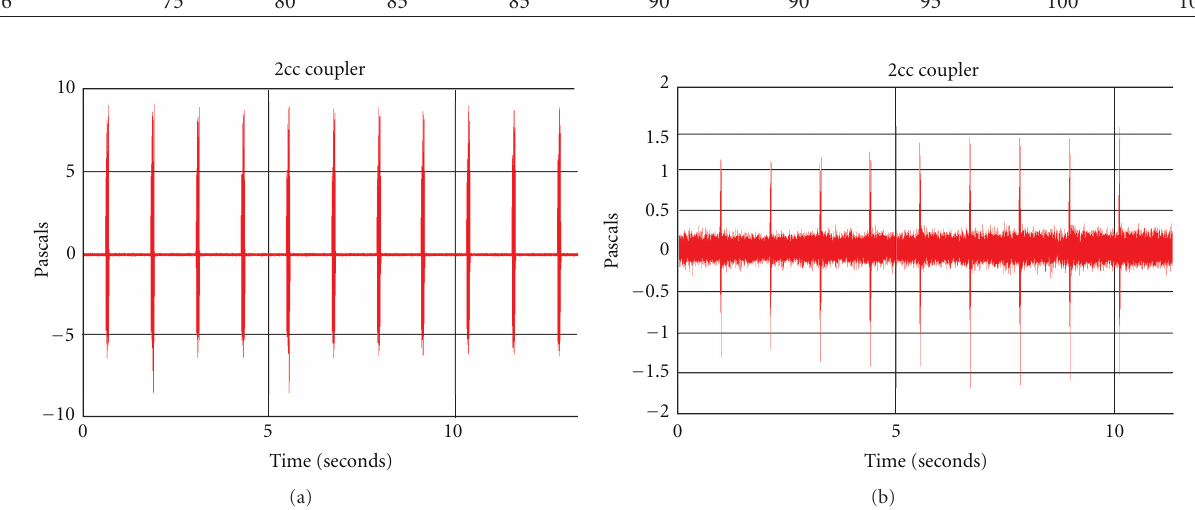
Figure 1: (a) illustrates the amplitude-time waveform of the output of one of the hearing aids when the stimulus /a/ was presented at 65 dB SPL. The hearing aid was programmed to DSL v5 targets derived for the audiogram N4. The first few repetitions are more variable than the later repetitions. (b) illustrates the amplitude-time waveform of the output of one of the hearing aids when the stimulus /g/ was presented at 55dB SPL. The hearing aid was programmed to DSL v5 targets derived for the audiogram N4. The first few repetitions are lower in level compared to the later